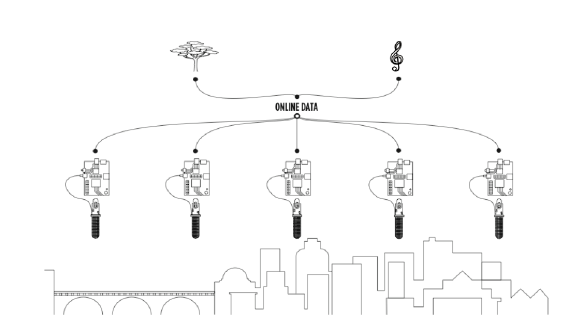
Figure 1 | URB system (illustration by Diogo